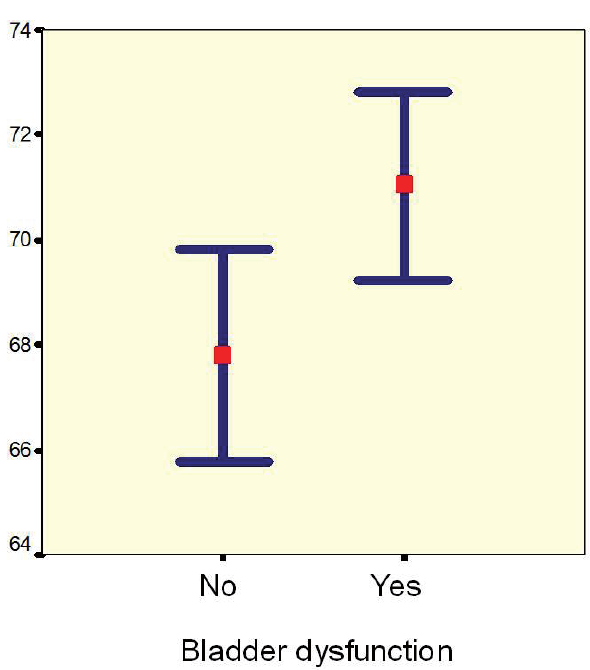
Figure 1 - Mean patients age according to the prevalence of bladder dysfunction (p =